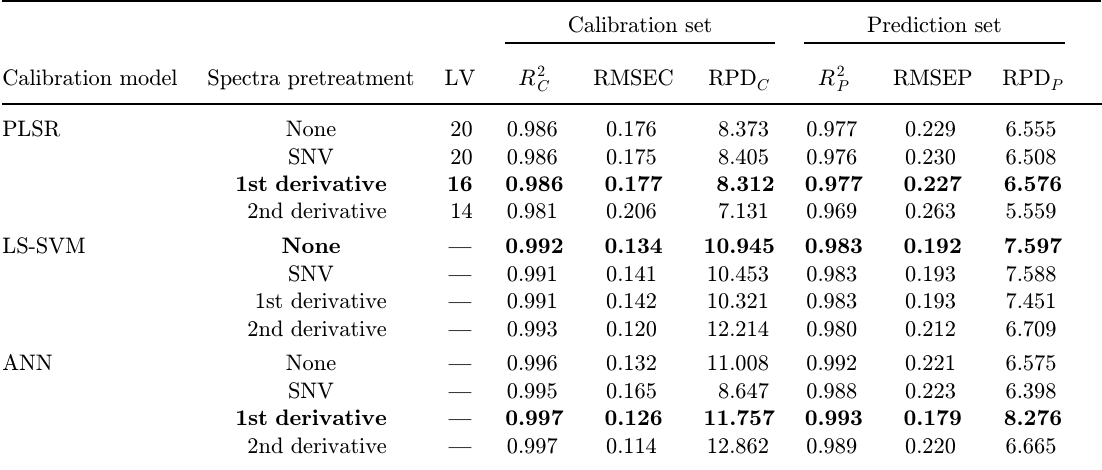
Table 2. Statistical comparison of di®erent NIR calibration models. Calibration set Prediction